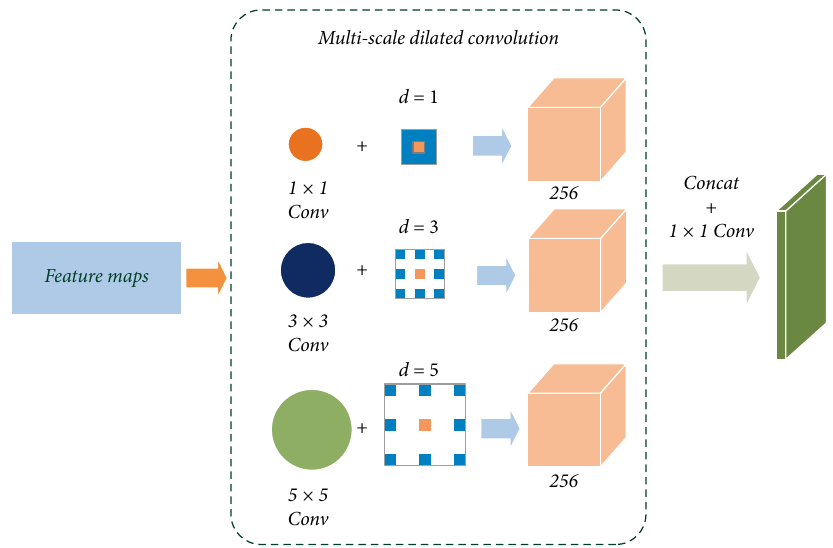
Figure 3: Multiscale dilated convolution module.